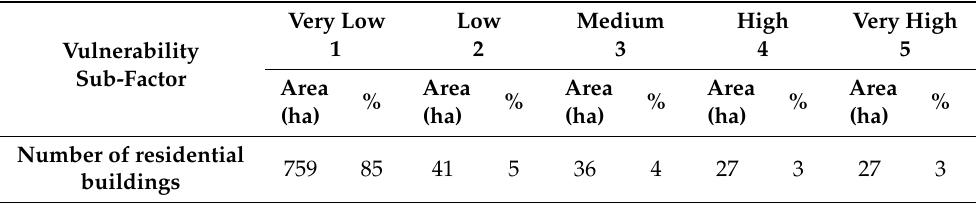
Table 29. The areas classified with very high vulnerability correspond to Cova do Vapor, a small strip in Bairro do Torr ã o, a strip in S ã o Jo ã o, the built area near the base of the fossil cliff in Quinta de Santo Ant ó nio, some areas of Costa da Caparica and some areas in Terras da Costa. Table 29. Areas and percentages of the study area classified as each class of the residential buildings (number of residential buildings) vulnerability sub-factor.